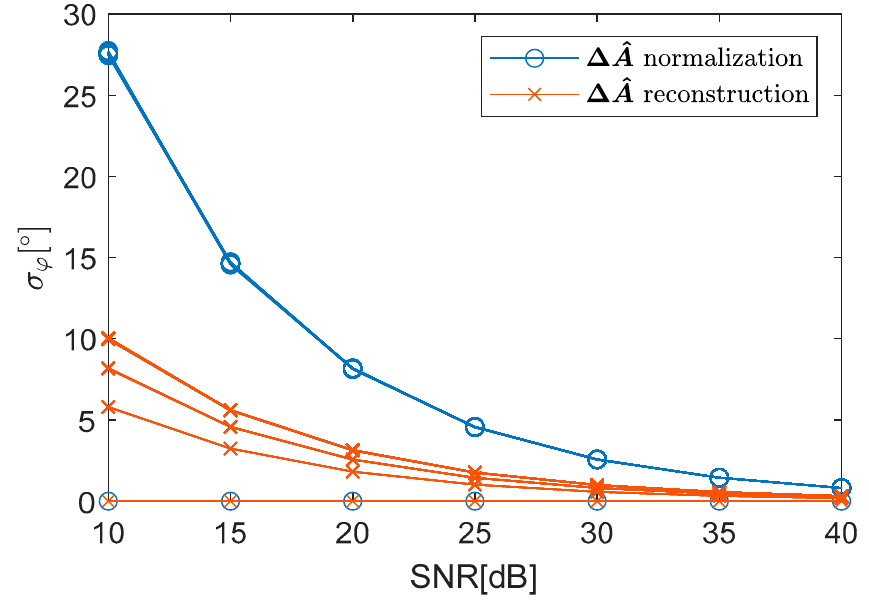
Figure 8. The standard deviation of phase for coefficients of estimated channel matrix ∆ ˆ A .